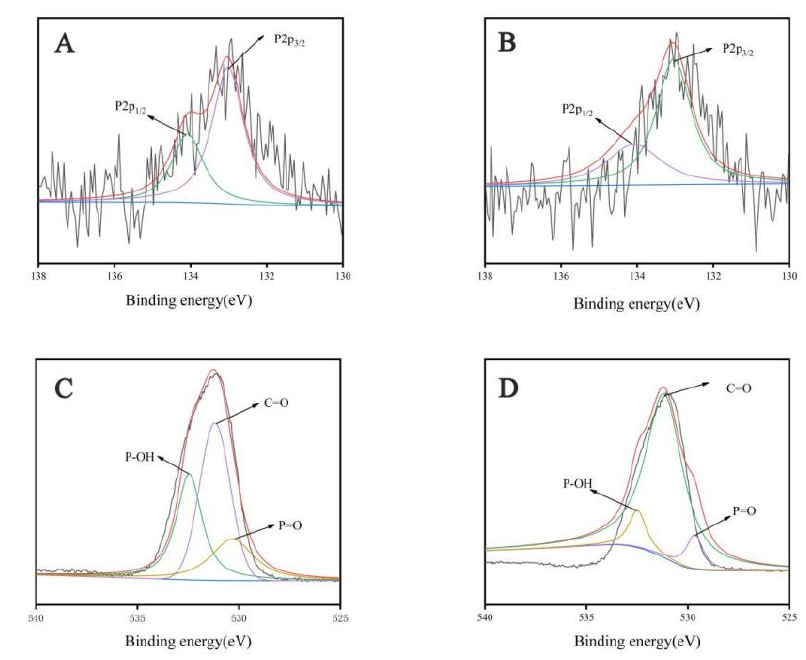
Figure 6. ( A ) P 2p map of Fe 3 O 4 /P (GMA ‐ MBA) ‐ PO 4 ; ( B ) P 2p map of Fe 3 O 4 /P (GMA ‐ MBA) ‐ PO 4 ‐ U; ( C ) O 1s map of Fe 3 O 4 /P (GMA ‐ MBA) ‐ PO 4 ; ( D ) O 1s map of Fe 3 O 4 /P (GMA ‐ MBA) ‐ PO 4 ‐ U .